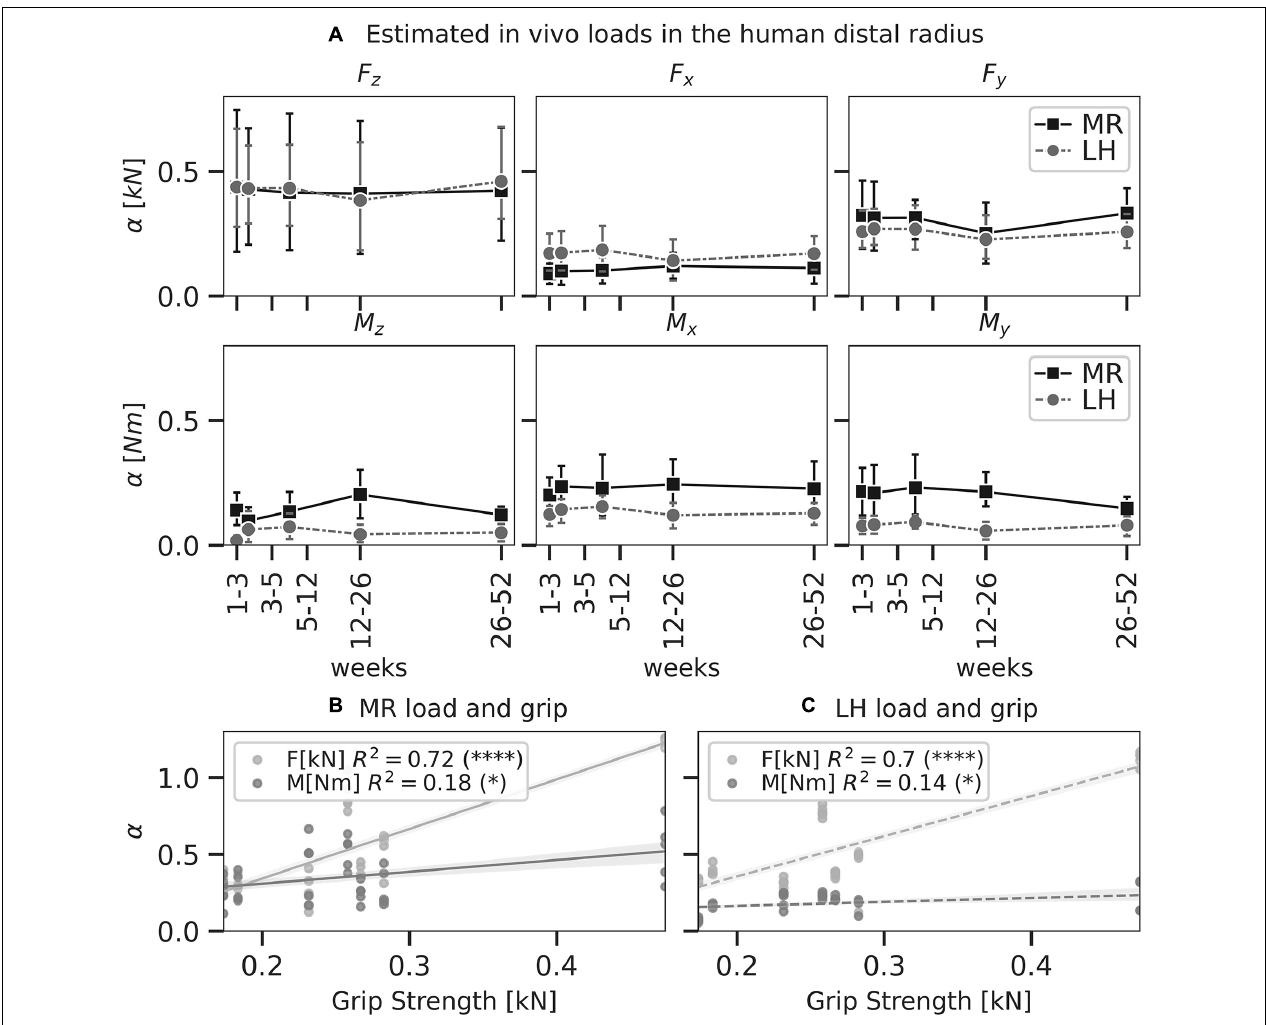
FIGURE 6 | Load as predicted by mechanoregulation-based load estimation (MR; solid) and load history (LH; dashed) of physiological load in the human distal radius ( n = 7). In panel A , line plots show mean predicted load and 95% confidence intervals for each component of a six-degree freedom load. No significant differences were found between MR and LH ( p < 0.05, paired t -test). Linear regressions between grip strength and total force (cid:54) F i and moment (cid:54) M i as predicted by MR (B) and LH (C) were calculated. Significant correlations indicated ( ∗ p < 0.05; ∗∗∗∗ p <